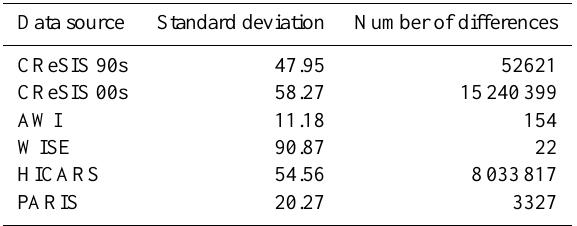
Table 2. Inter-track differences for intra-instrument campaigns: i.e. the differences are only estimated for CreSIS vs. CreSIS, AWI vs. AWI,